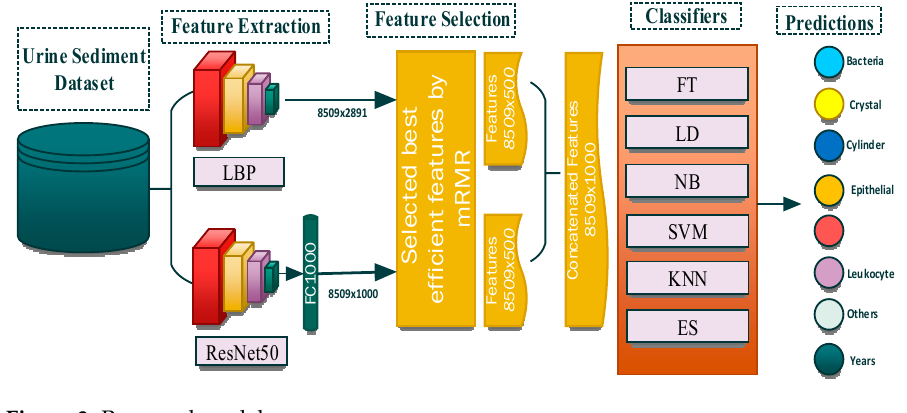
Figure 3. Proposed model.